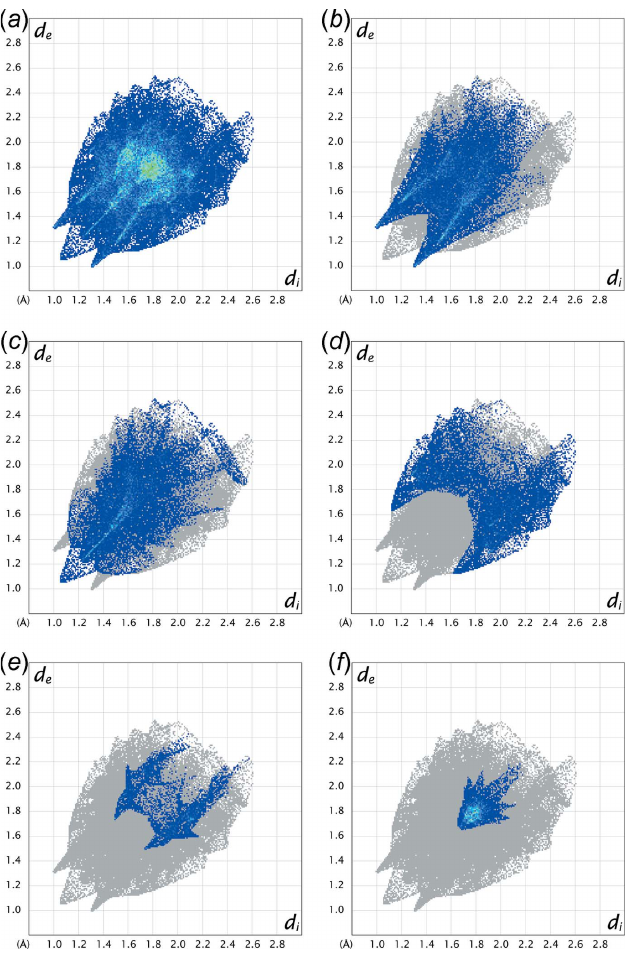
Figure 4 The two-dimensional fingerprint plots of 1 (cid:3) for ( a ) all, ( b ) H (cid:4)(cid:4)(cid:4) O/O (cid:4)(cid:4)(cid:4) H, ( c ) H (cid:4)(cid:4)(cid:4) H, ( d ) H (cid:4)(cid:4)(cid:4) C/C (cid:4)(cid:4)(cid:4) H, ( e ) O (cid:4)(cid:4)(cid:4) C/C (cid:4)(cid:4)(cid:4) O and ( f ) C (cid:4)(cid:4)(cid:4) C contacts. d i and d e are the distances from the Hirshfeld surface to the nearest atom interior and exterior, respectively, to the surface. 25.4 and 26.5% of the total intermolecular contacts of 1 (cid:2) and 1 (cid:3) , respectively. The shortest H (cid:4) (cid:4) (cid:4) H contacts of 1 (cid:2) (symmetry code: (cid:3) x , (cid:3) y , (cid:3) z + 1) and 1 (cid:3) (symmetry code: (cid:3) x , y , (cid:3) z (cid:3) 1